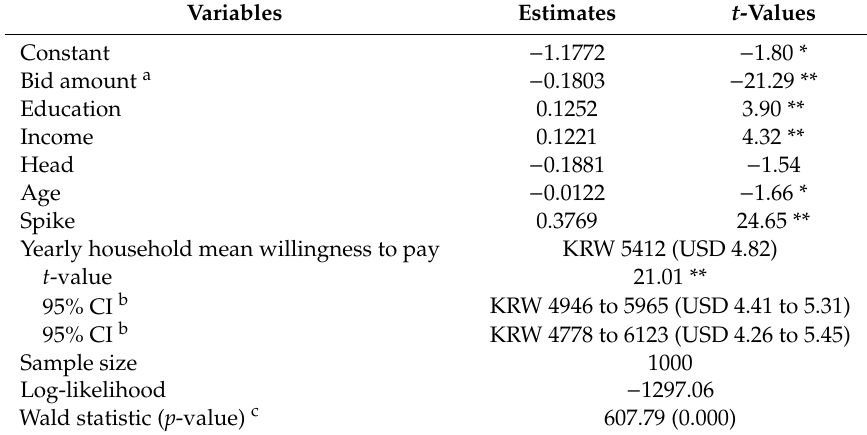
Table 4. Estimation results of the model containing the variables described in Table